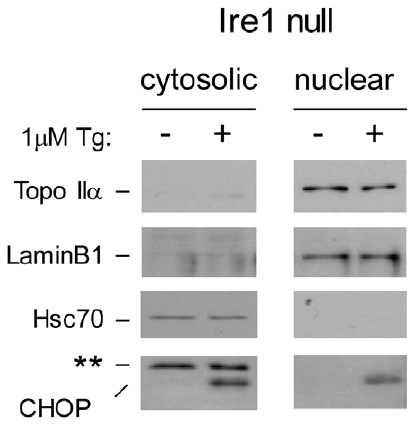
Figure 3. Decreased sensitivity to etoposide in Ire1 null cells that maintain Topo II a expression is not linked to UPR induced changes in its localization. Ire1 knockout cells were treated with or without thapsigargin for 6 hrs and cells were homogenized and separated into a nuclear pellet and the cytosol. Fractions were subjected to western blotting with the indicated antibodies. LaminB1 serves as a control for the nucleus and Hsc70 for the cytosol. The asterisk indicates a non-specific band observed with the anti-CHOP